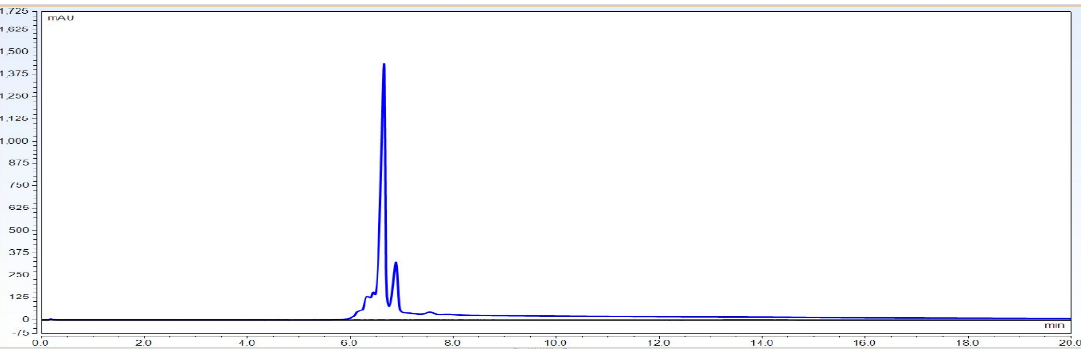
Figure 9. Representative chromatographic overlay data for IgG1 sample and buffer blank run. These data show that the method is specific enough to claim charge variants analysis and that it has no matrix interference at IgG1 peak elution.